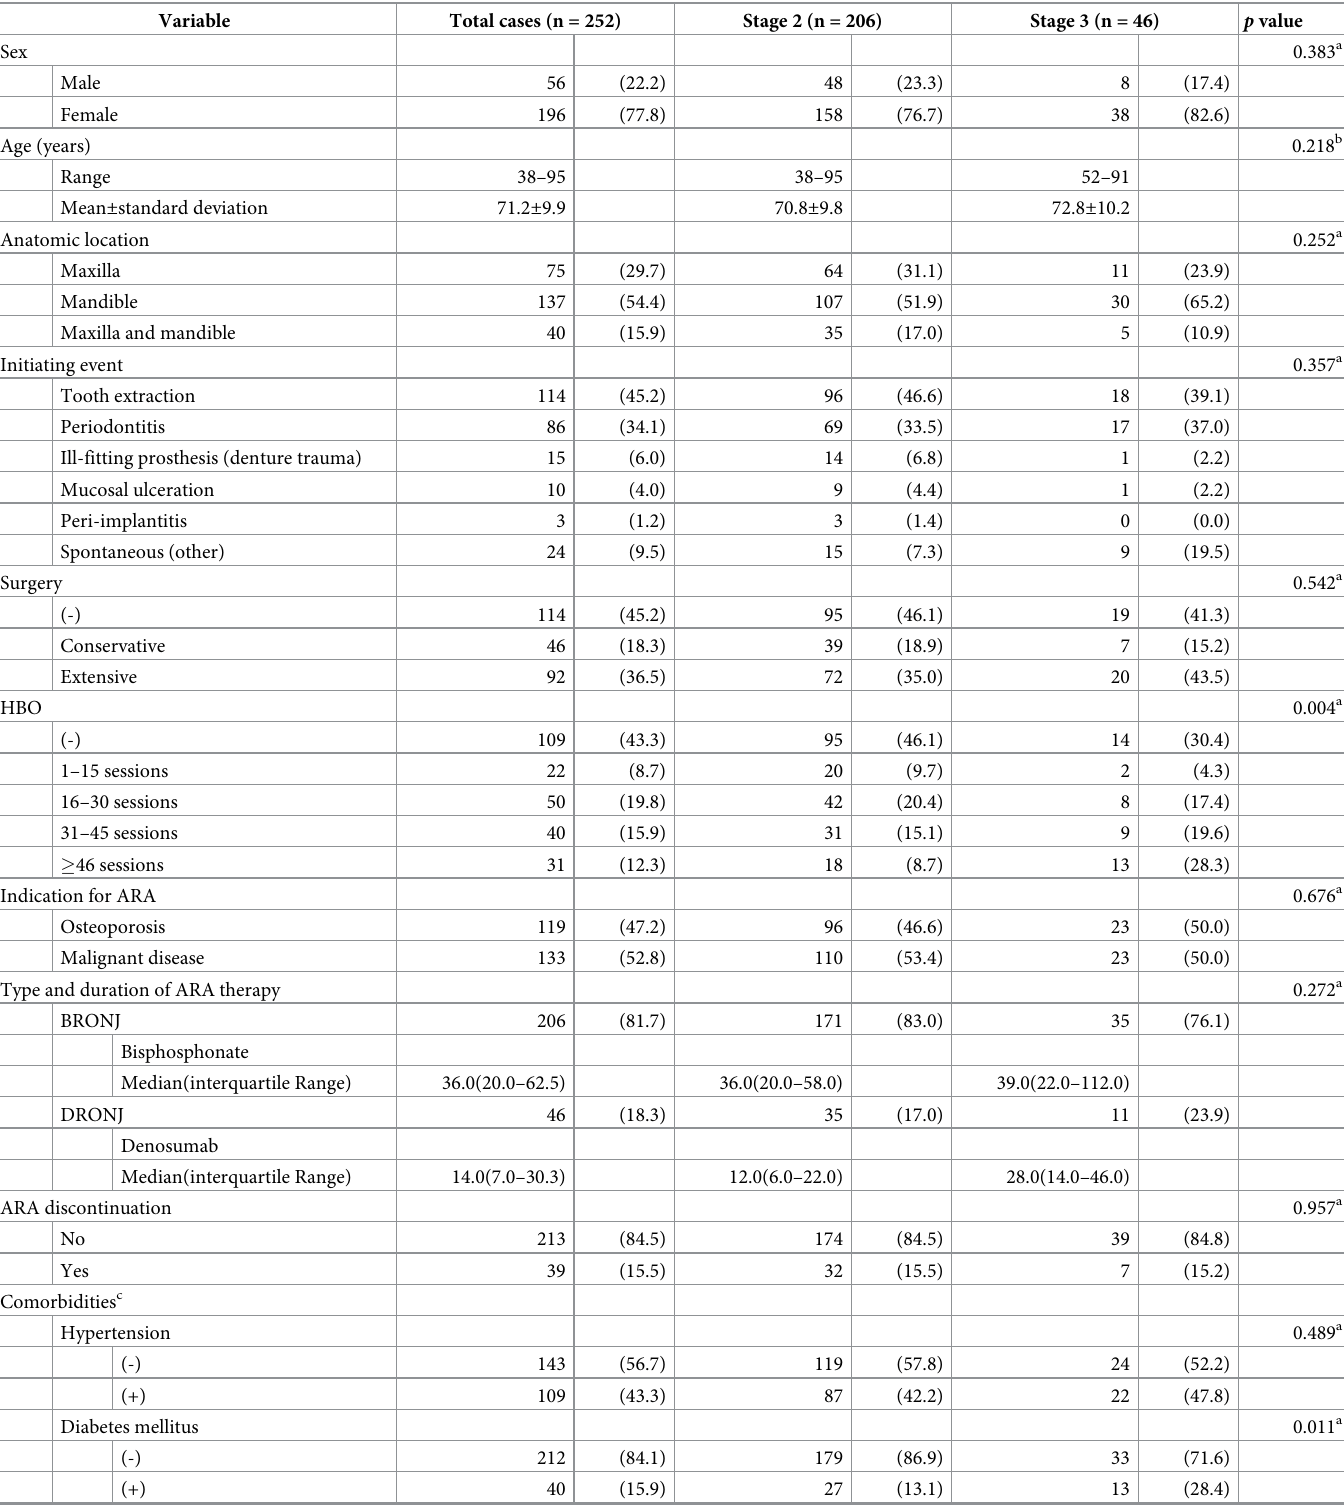
Table 1. Characteristics of the study